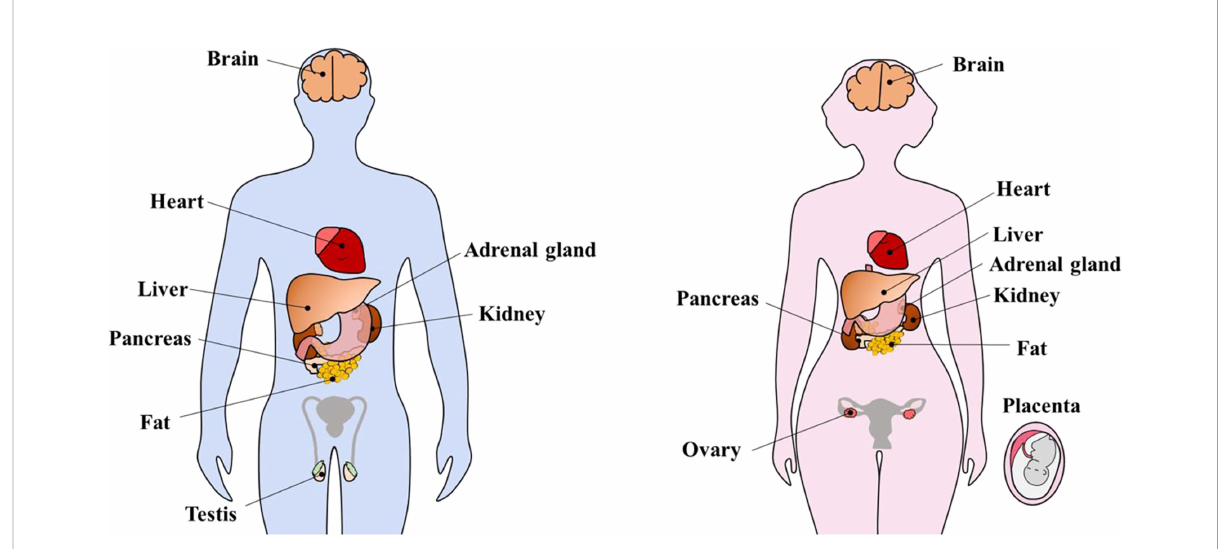
FIGURE 3 Extrahypothalamic kisspeptins and kisspeptin receptors. Kisspeptins (KPs) and kisspeptin receptors (KPRs) are expressed in several extrahypothalamic sites inside the brain as well as peripheral organs including heart, liver, adrenal gland, pancreas, kidney, fat, testis, and ovary. During pregnancy, KP expression increases tremendously, in part due to placental